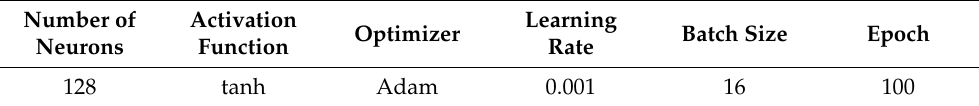
Learning Batch Size Epoch Rate